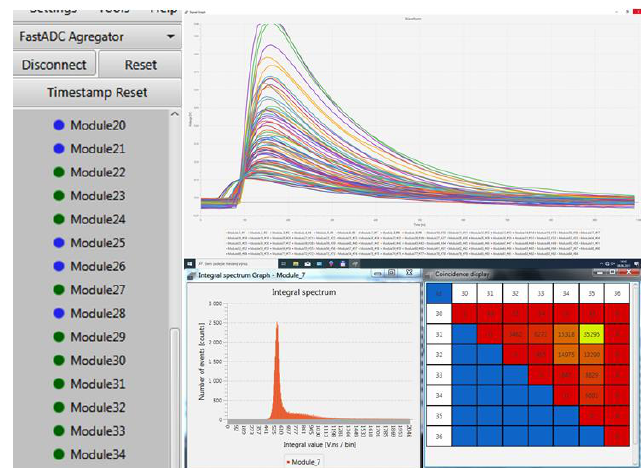
Fig. 5. The DAQ software showing information about the status of each channel (left), signals from 80 channels, energy spectrum from one chosen channel and number of coincidences between two channels.